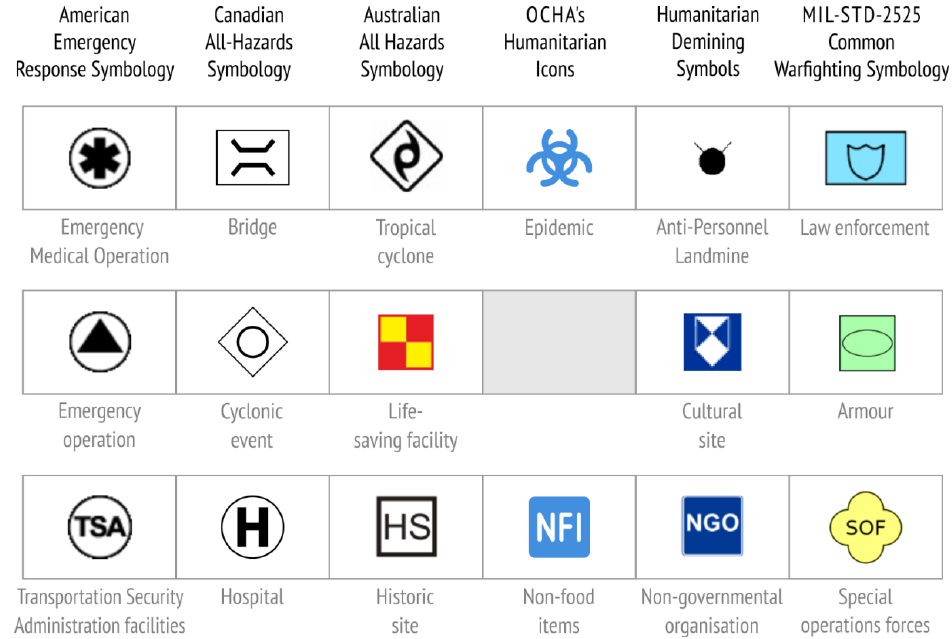
Figure 4. Selected examples of associative (top), geometric (middle) and alphanumeric (bottom) symbols in the analysed symbol sets. symbols in the analysed symbol